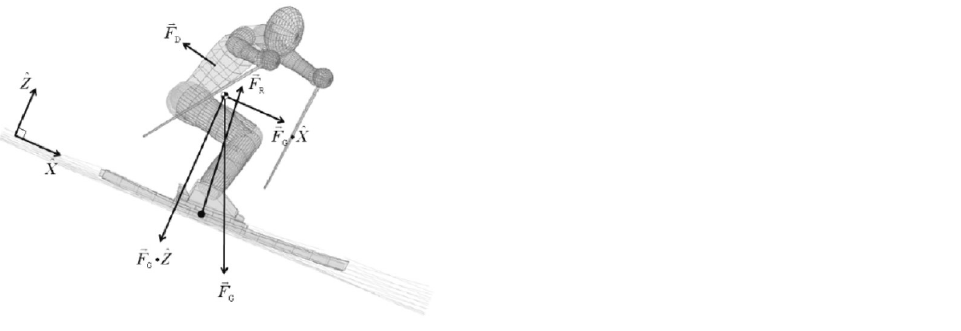
Figure 5. Force analysis diagram 15 .